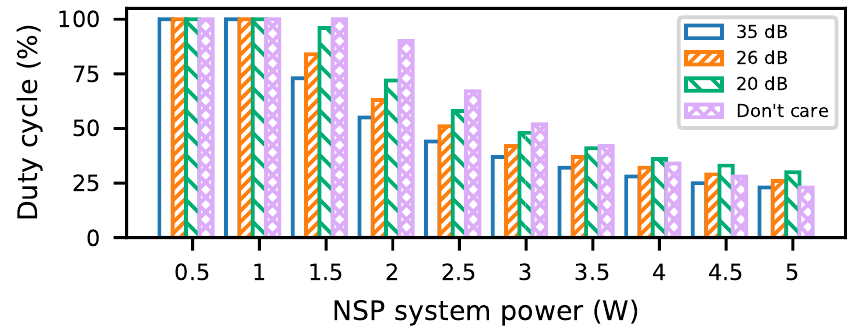
Figure 7. Influence of fidelity and NSP power on duty cycle.